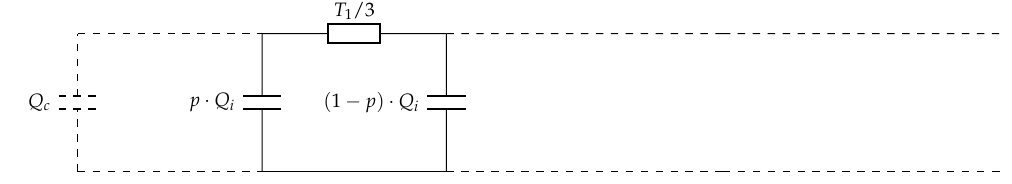
Figure 10. Transient representation of thermal parameters for insulation.